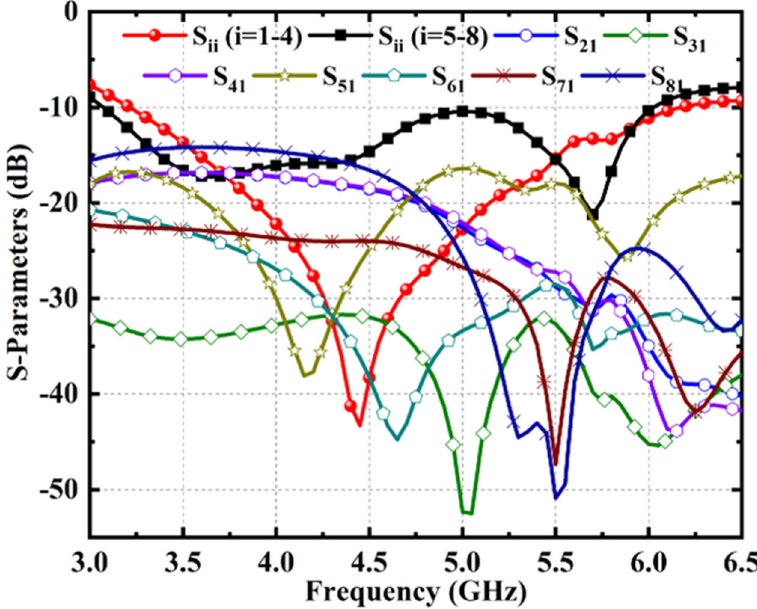
Figure 8. Eight–element MIMO antenna S–parameters